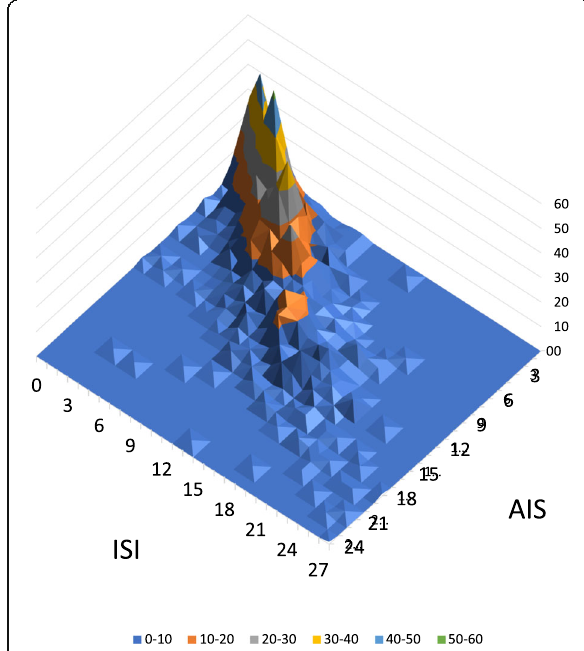
Fig. 1 Athens Insomnia Scale (AIS) and Insomnia Severity Index (ISI) three-dimensional histogramThe height (z-axis) represents the number of subjects, with the ISI and AIS scores shown in the x- and y-axis,